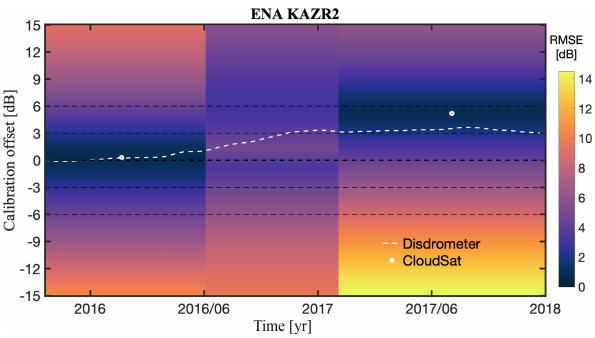
Figure 8. The ENA KAZR2 calibration offset as reported by the CloudSat–ARM comparison (star symbol) and by the KAZR2 and Parsivel disdrometer comparison (line). The colors indicate the RMSE of the CloudSat–ARM comparison for different radar cal- ibration